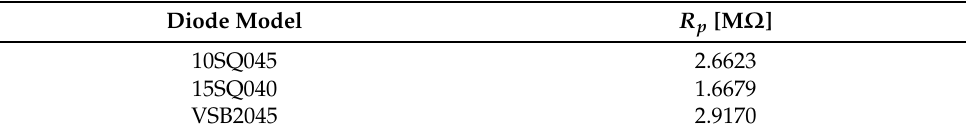
Table 7. R p for the three diodes.